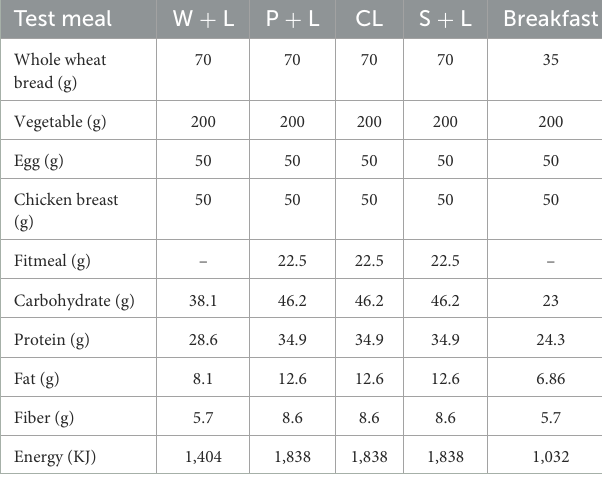
TABLE 2 Composition and nutrient content of test